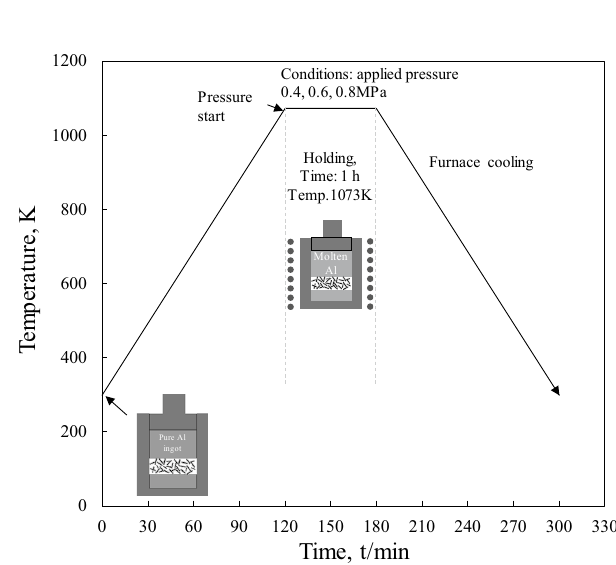
Figure 1. Manufacturing process of short carbon fiber reinforced Al composite by